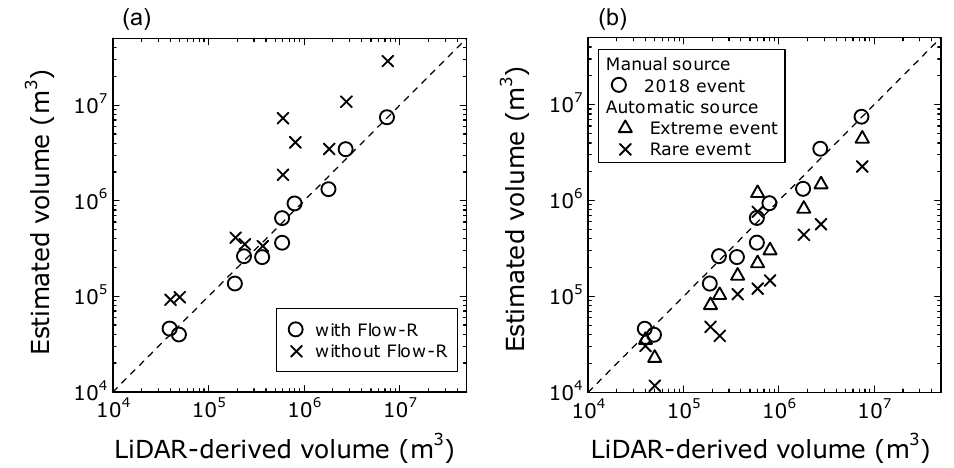
Figure 13. ( a ) Comparison of volume estimations with and without using Flow-R-based propagation analysis. ( b ) Comparison of volume estimations based on manual sources and automatic sources in Flow-R analysis.